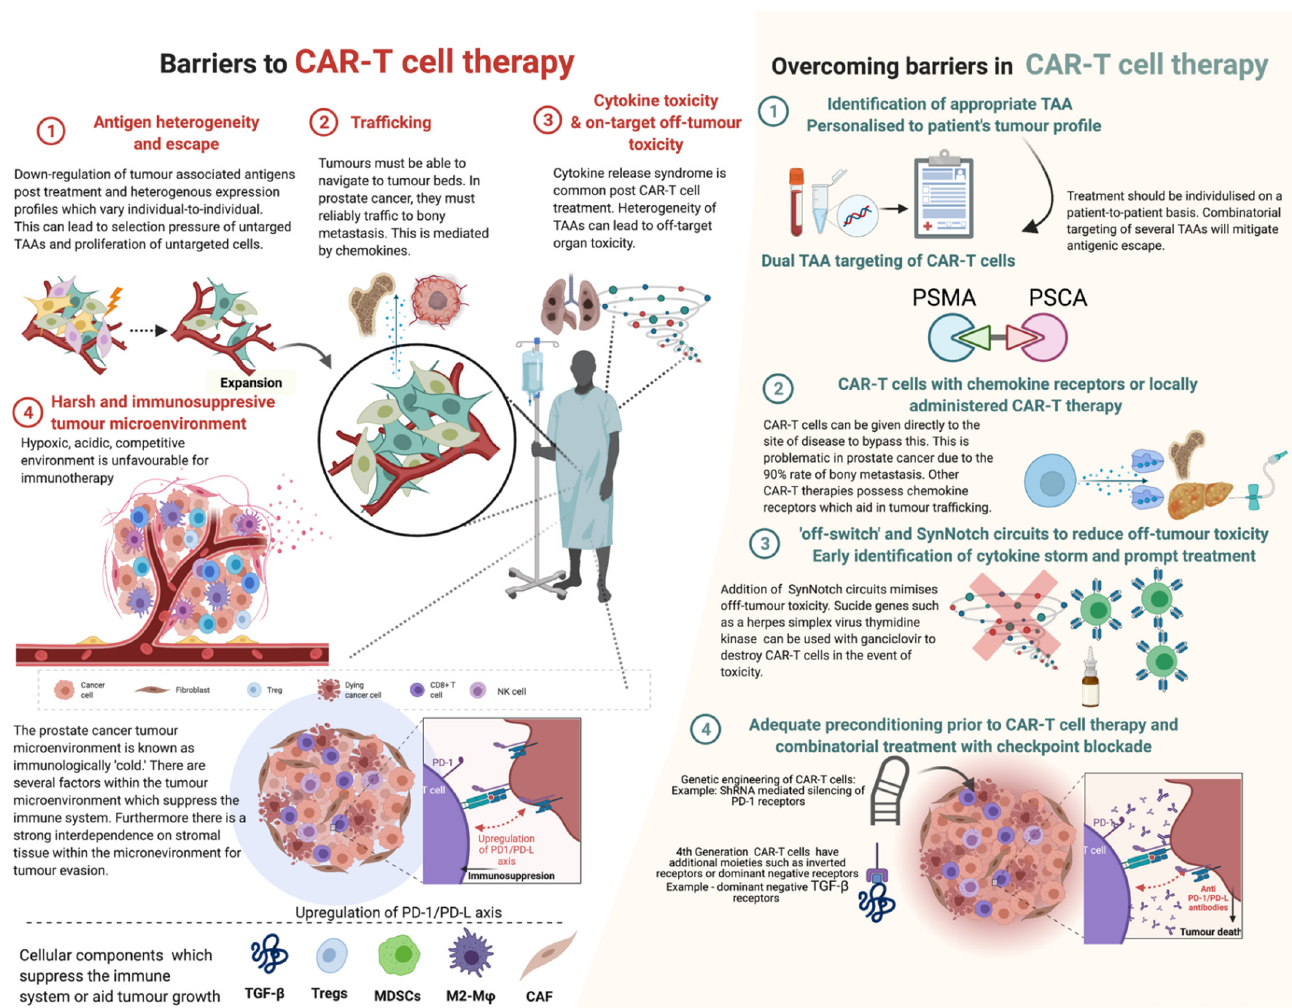
Figure 3. Barriers in CAR-T cell therapy and strategies adopted in overcoming these barriers. Abbreviations: TGF- β —tumour growth factor beta; Tregs—T regulatory cells; MDSCs—myeloid-derived stem cells; M2-M φ —M2 macrophages; CAF—cancer-associated fibroblasts; PD-1—programmed cell death type 1; PD-L—programmed death ligand; shRNA—short hairpin RNA. Created with BioRender.com (accessed on 1 December 2021).